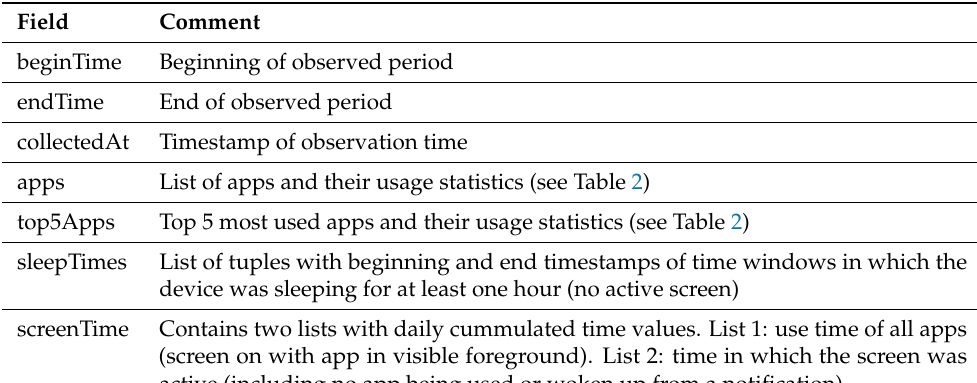
Table 1. Data collected about app usage in Corona Health (Android).